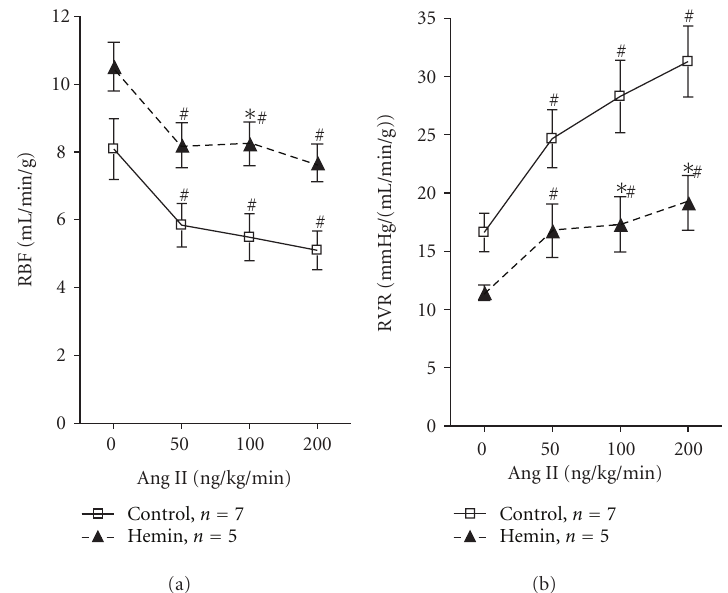
Figure 5: Changes in RBF and RVR in response to infusion of angiotensin II in hemin-treated rats ( n = 5) compared to control rats ( n = 7). Results are expressed as mean ± SE for each group, ∗ P < 0 . 05 versus Control, # P < 0 . 05 versus baseline before angiotensin II infusion.